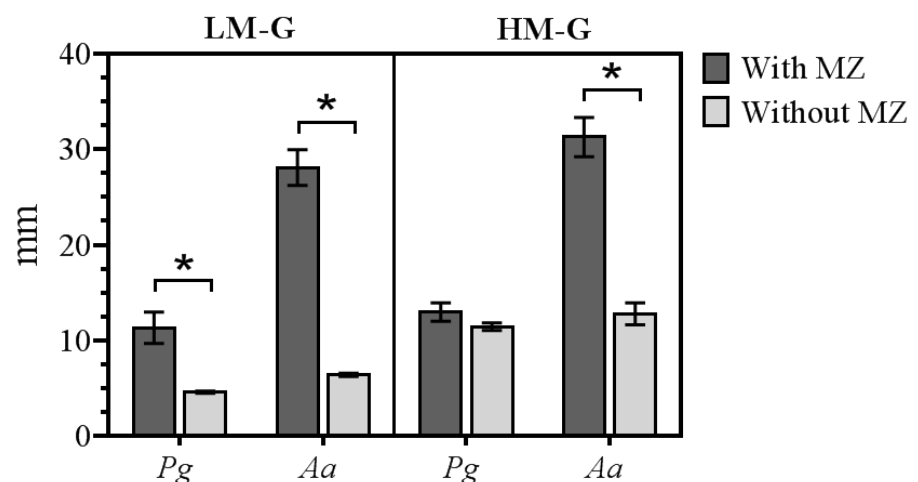
Figure 4. Differential inhibition of bacterial growth illustrated by the inhibition zone. The average diameter ± standard deviation (in mm) of inhibition zones of LM-G and HM-G films loaded metronidazole ( n = 3) against the growth of P. gingivalis ( Pg ) and A. actinomycetemcomitans ( Aa ) was shown. LM-G and HM-G films (depicted in grey bars) without metronidazole served as negative controls. Statistical difference was determined by using paired t -test to determine the significance, indicated by asterisk (*), at p < 0.05.